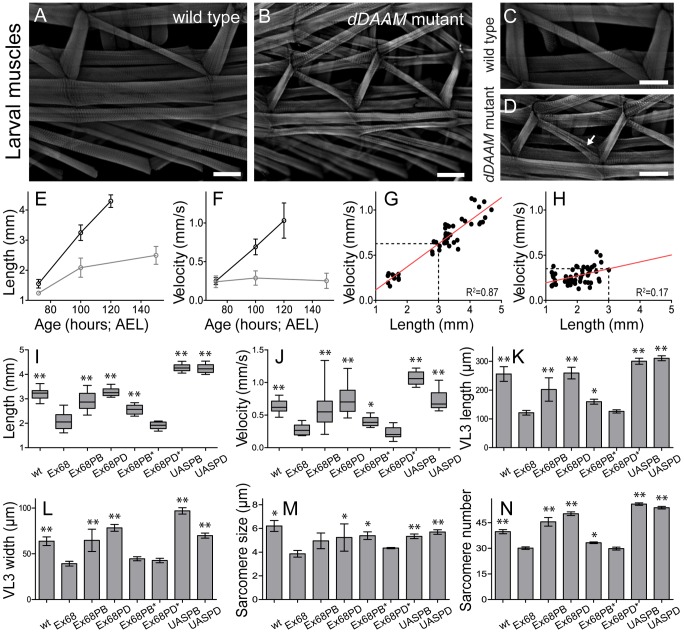
Structural and functional analysis of the larval body wall muscles.Wild type (A, C) and dDAAMEx68 null mutant (B, D) larval body wall muscles stained with phalloidin. Mutant muscles are smaller, some myofibers are split (arrow on D) and the overall muscle pattern is looser than in wild type. The relationship of larval age and length (E), and of larval age and velocity (F) in wt (wild type; black line) and dDAAMEx68 (grey line) larvae. The relationship of larval length and velocity of wt (G) and dDAAMEx68 mutant (H) larvae. Quantification of larval length (I), crawling velocity (J), VL3 muscle length (K), width (L), mean sarcomere length (M) and serial sarcomere number (N) in larvae 100 hours AEL with the following genotypes: wt (wild type), Ex68 (dDAAMEx68), Ex68PB (dDAAMEx68; DMef2-Gal4; UAS-dDAAM-PB), Ex68PD (dDAAMEx68; DMef2-Gal4; UAS-dDAAM-PD), Ex68PB* (dDAAMEx68; DMef2-Gal4; UAS-dDAAM-PBI732A), Ex68PD* (dDAAMEx68; DMef2-Gal4; UAS-dDAAM-PDI732A), UASPB (DMef2-Gal4; UAS-dDAAM-PB) and UASPD (DMef2-Gal4; UAS-dDAAM-PD). Bars represent mean values with respective SDs in I–N. Statistical significance: * 0.05>p<0.001; ** p≤0.001. Wild type and rescue data were compared to dDAAMEx68 data, unless otherwise indicated in the text. Bars, 100 µm (A–D).